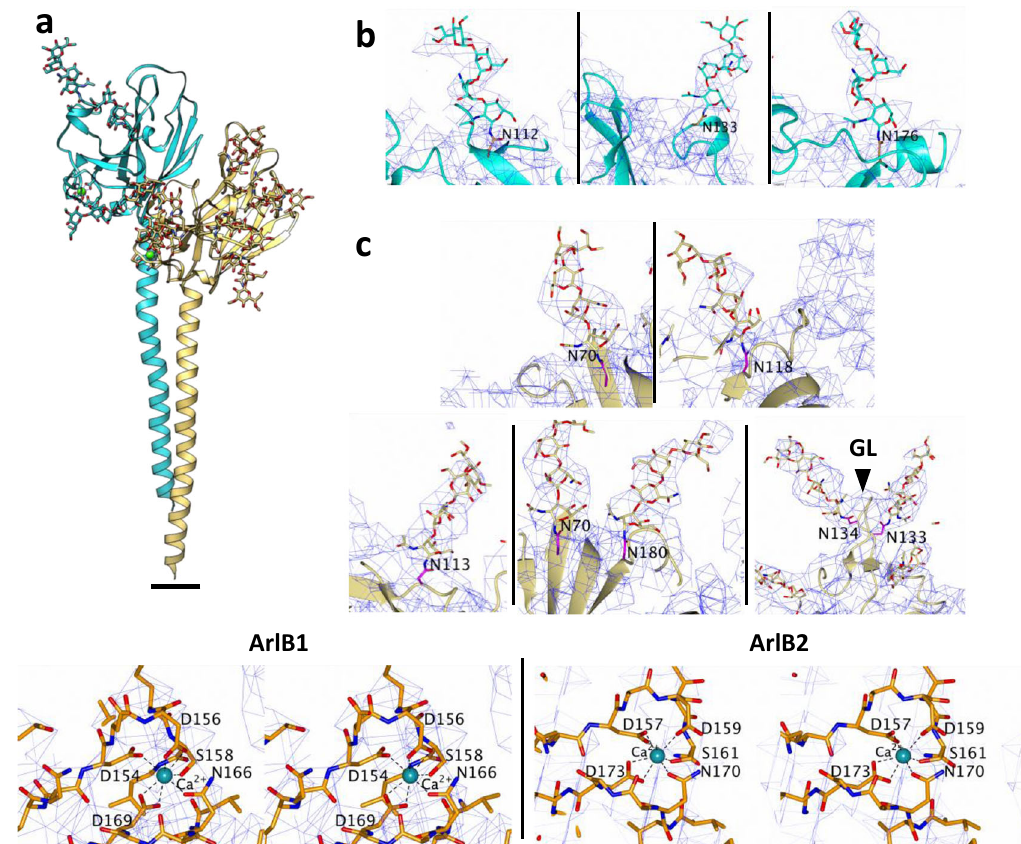
Fig. 3 Glycosylation and metal-binding sites in ArlB1 and ArlB2. a Atomic models of ArlB1 (cyan) and ArlB2 (sand) are shown in ribbon representation with modelled glycan molecules, side chains of metal and glycan binding residues shown as stick models and metal ions highlighted as green spheres. Scale bar in a , 10 Å. b Close-ups of the three glycosylation sites in ArlB1. c Close-ups of the six glycosylation sites in ArlB2. GL glycosylation loop. d Stereo views of ArlB1 and ArlB2 metal-binding sites. The cryoEM map is represented as a blue mesh and contoured at 2.8 σ . Protein chain is shown as a stick model, Ca 2 + ion is shown as a cyan sphere with metal-coordinating residues